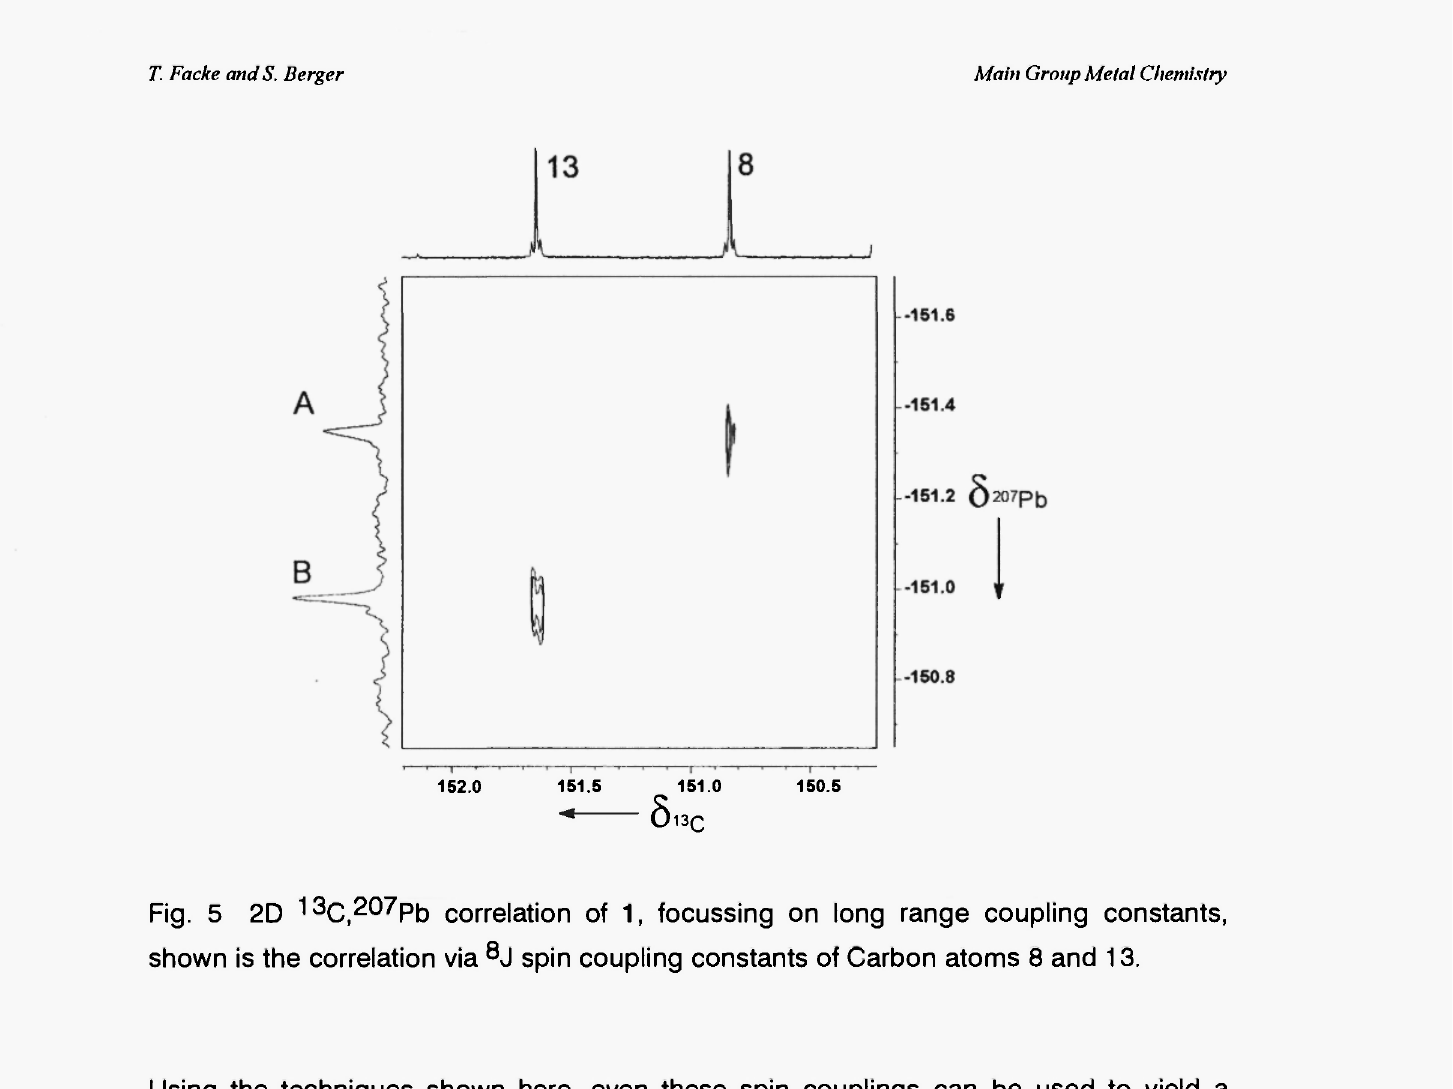
Fig. 5 2D 13 C, 207 Pb correlation of 1, focussing on long range coupling constants, shown is the correlation via 8 J spin coupling constants of Carbon atoms 8 and